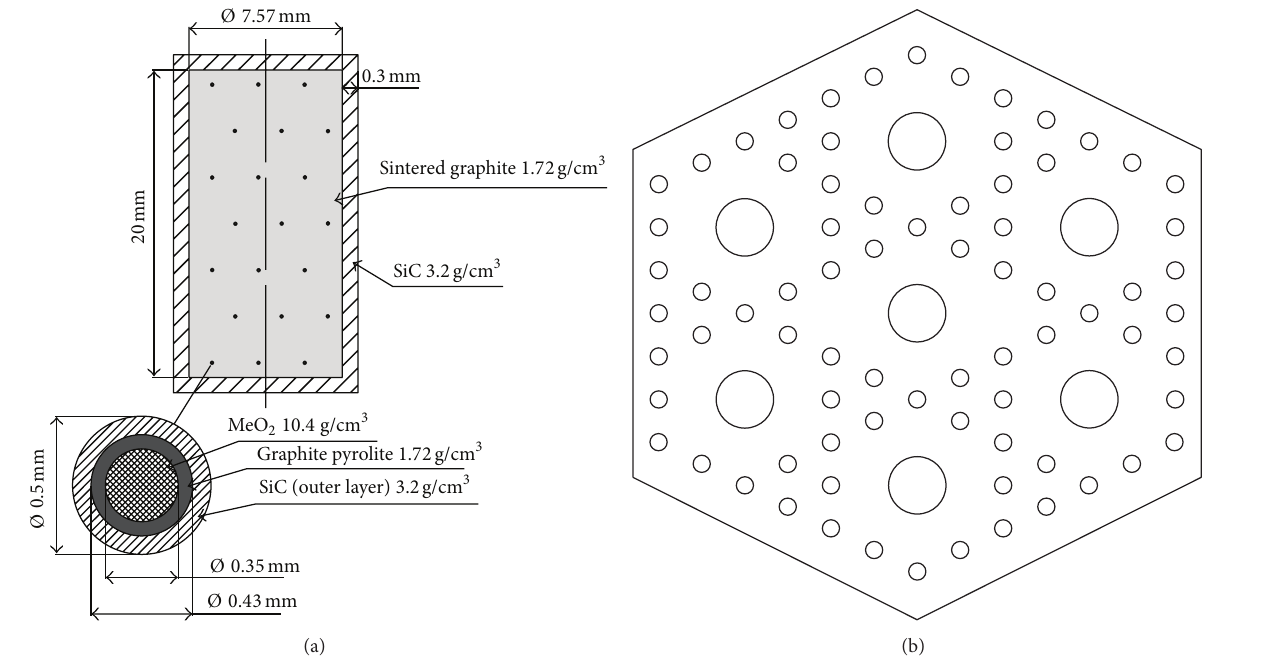
Figure 1: Calculation model of HTGTR fuel assembly: (a) 0500 and 1000 type fuel pellet of HTGTR; (b) HTGTR fuel assembly.